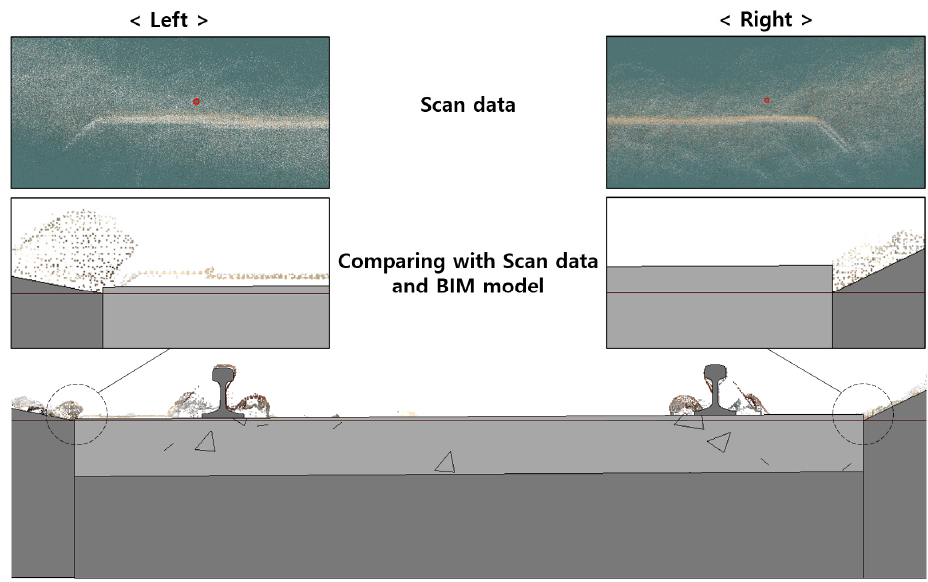
Figure 11. Sleeper exposure review.